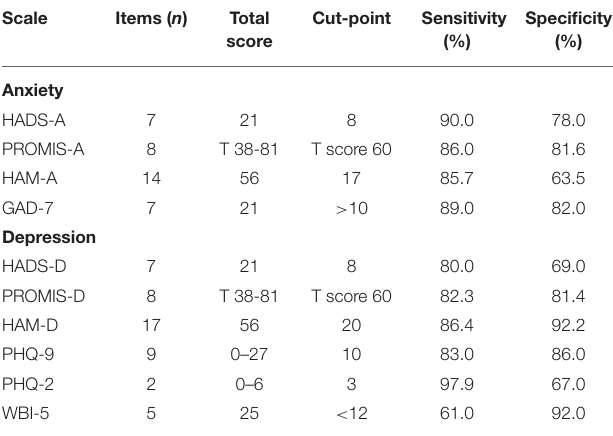
TABLE 1 | A summary of the characteristics of the scales.